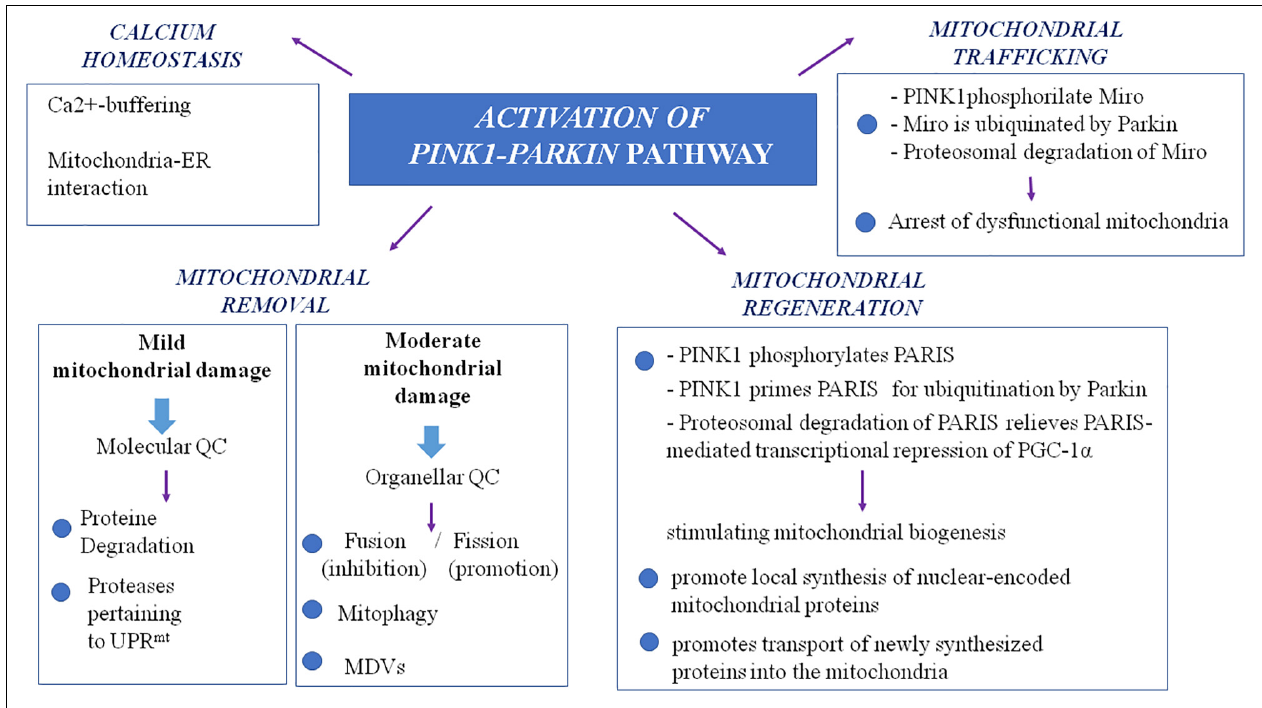
FIGURE 1 | The complex role of PINK1/Parkin pathway in mitochondria. MDVs, mitochondrial-derived vesicles; QC, quality control; PARIS, Parkin interacting substrate; PGC-1alpha, peroxisome proliferator-activated receptor-gamma coactivator; UPRmt, mitochondrial unfolded protein